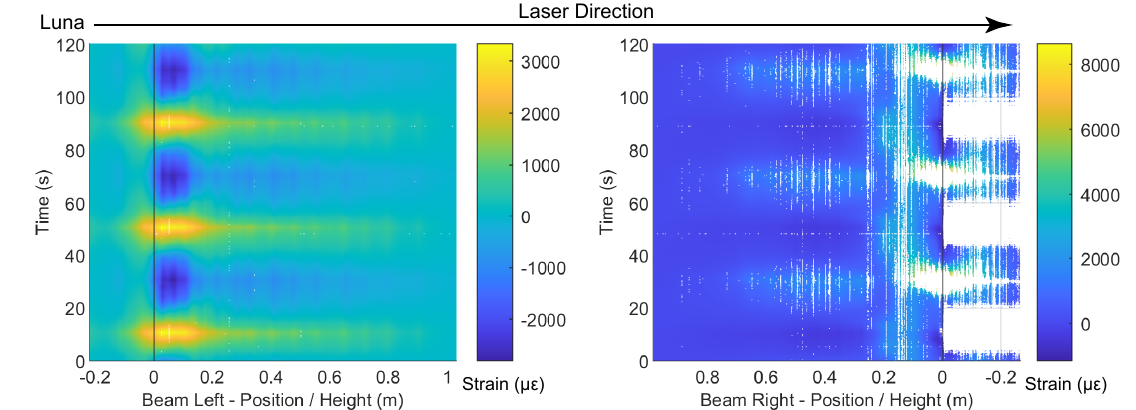
Figure 16. Contour of the fiber-optic strain measurements for Silicon-PFA cable at a drift level of 0.95%.